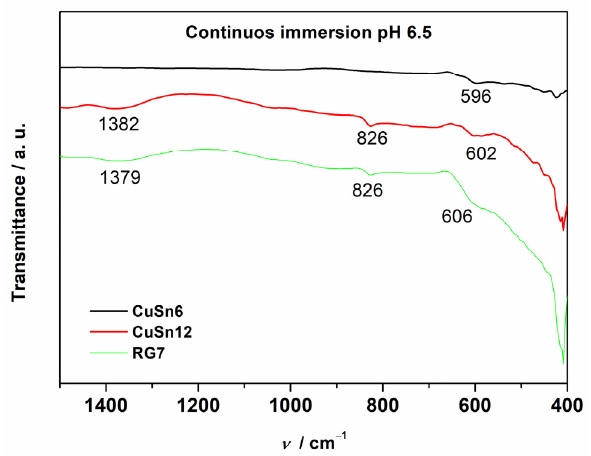
Figure 14. FTIR spectrum for continuous immersion of bronzes in acid rain at pH 6.5.